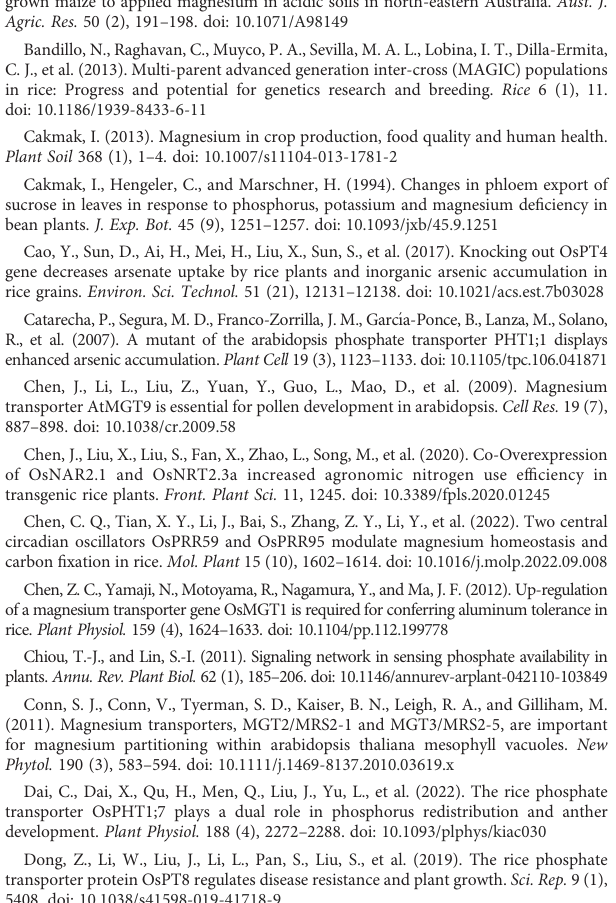
SUPPLEMENTARY FIGURE 1 Topological model of proteins encoded by candidate genes. The probability of transmembrane location predicted by the TMHMM algorithm (https:// services.healthtech.dtu.dk/service.php?TMHMM-2.0). Red areas indicate predicted TM spans. SUPPLEMENTARY FIGURE 2 Expression of the candidate genes in yeast mutant CM66 in liquid medium. Yeast strains were grown in liquid media with (A) 4mmol/L MgSO 4 , (B) 64 mmol/L MgSO4, or (B) 128 mmol/L MgSO 4 for 75 h. The absorbance at 600 nm (OD600) of cell cultures was measured every 5 h. Values are mean ± SE ( n = 3). The asterisks above the bars indicate signi fi cant difference between lines at P < 0.01. SUPPLEMENTARY FIGURE 3 Sequence and expression of LOC_Os03g04430 and LOC_Os03g04480 in the four parental lines of the DC1 population. Gene structure of (A) LOC_Os03g04430 and (B) LOC_Os03g04480 and polymorphism locations (SNPs, asterisks). The SNPs are underlined with asterisks. Relative expression of (C) LOC_Os03g04430 and (D) LOC_Os03g04480 under different Mg 2+ concentrations. The rice seedlings in the 1/4 strength IRRI solution for two weeks, and in the full strength IRRI solution with 1 mM Mg 2+ (CK) or without Mg 2+ (-Mg) for three weeks. RNA was extracted from rice roots. Values are mean ± SE (n = 3). The different letters above the bars indicate signi fi cant difference between the control and treatments at P <